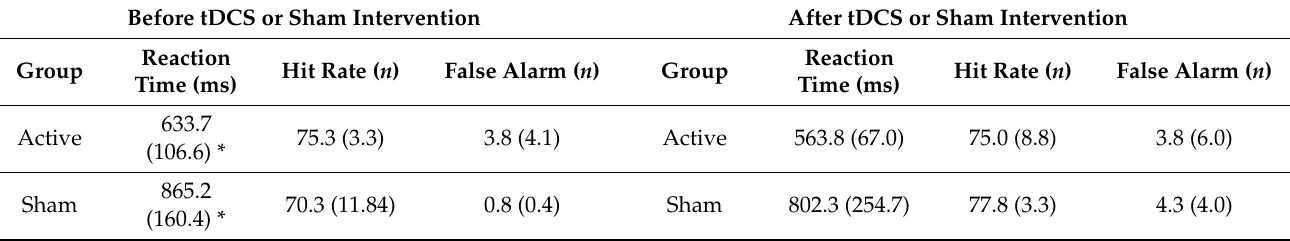
Table 1. Task performance of intervention groups and test